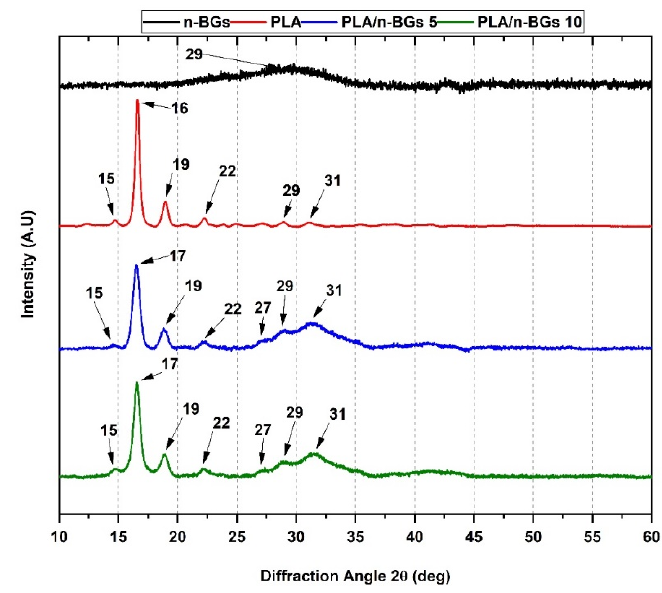
Figure 8. XRD analysis of neat PLA, PLA/n-BGs 5 wt.% and PLA/n-BGs 10 wt.%.